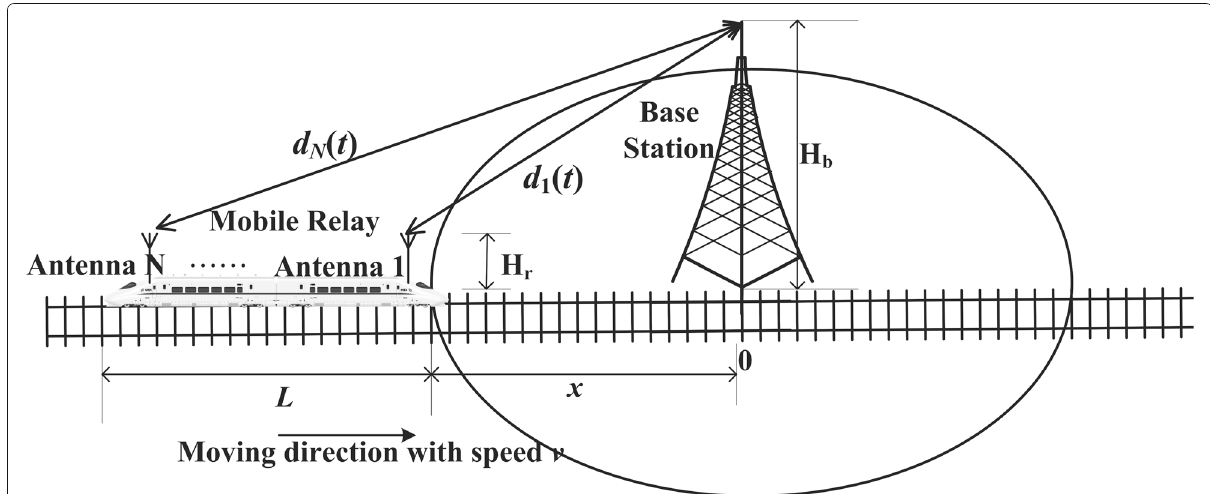
Fig. 1 The system model for HSR systems